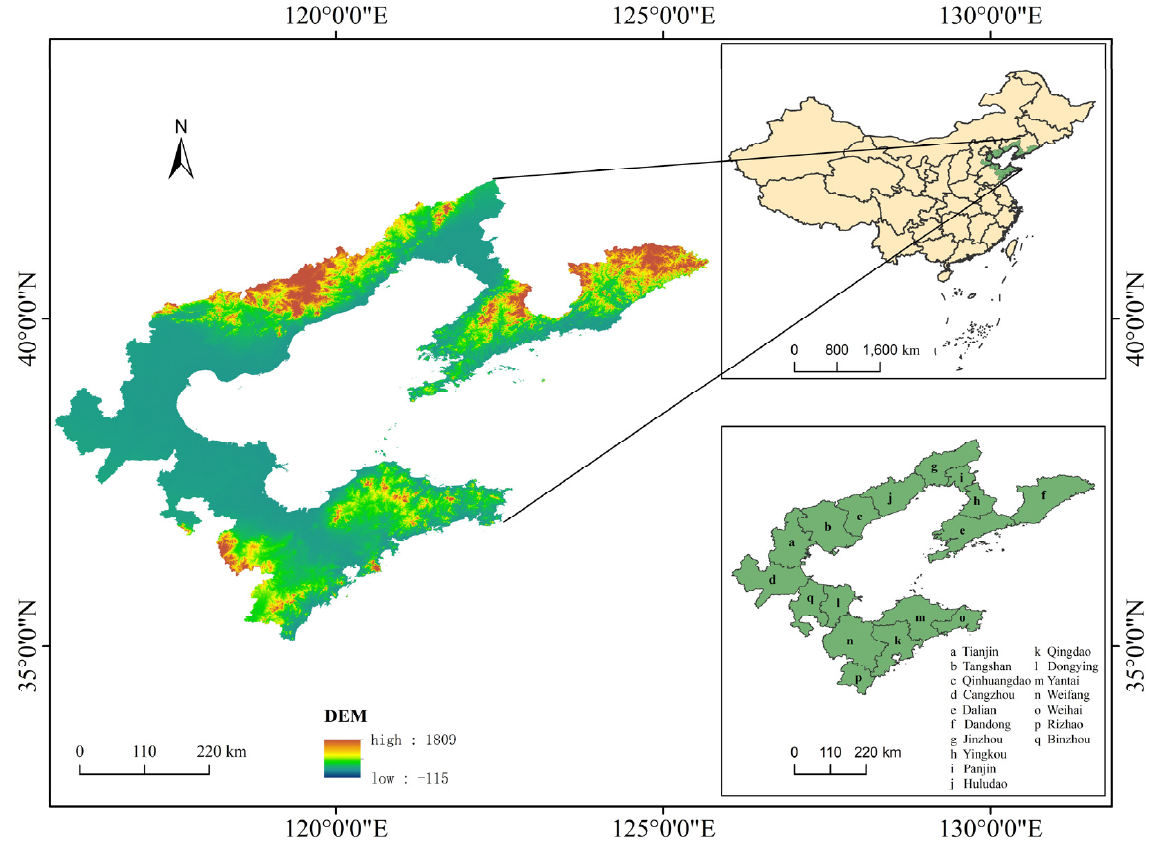
Figure 1. Location of the study area and the Circum-Bohai Sea, China. Source: geospatial data cloud.